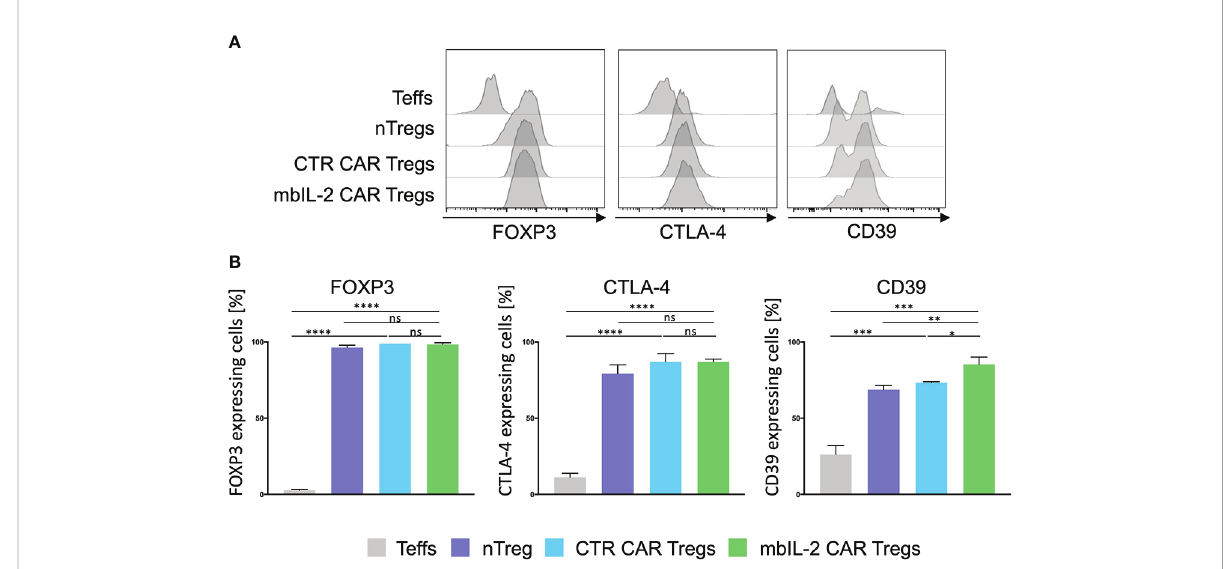
FIGURE 2 Expression of membrane-bound IL-2 did not alter the Treg phenotype. (A) Phenotype analysis of mbIL-2 CAR Tregs, CTR CAR Tregs and nTregs. CD4+CD25highCD127lowCD45RA+ Tregs from HLA-A*02 – negative donors were transduced with mbIL-2 CAR Tregs or CTR CAR Tregs and compared with nTregs for the expression of FOXP3, CD39, and cytotoxic T-lymphocyte – associated protein 4 (CTLA-4). Representative histograms are shown. (B) Bars summarizing all three independent experiments. Data are shown as the mean ± SD (n=3, 3 different PBMC donors; unpaired, two-tailed Student ’ s t test, ns, not signi fi cant; *P ⪬ 0.0120, **P ⪬ 0.01, ***P ⪬ 0.0002, ****P ⪬